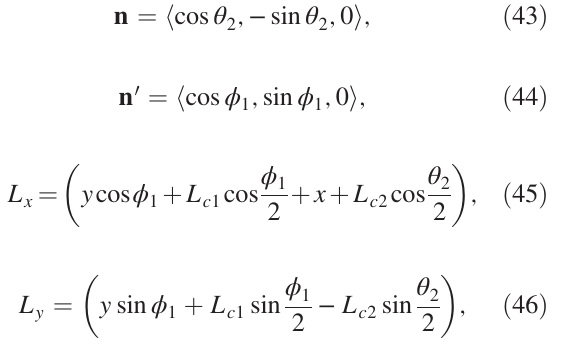
FIG. 4. Geometry for case